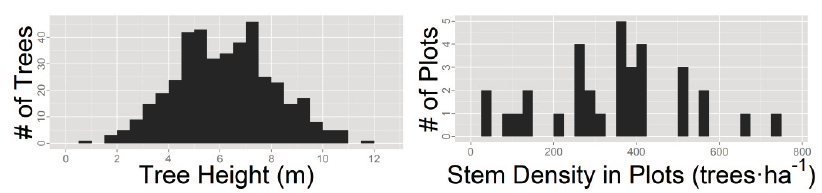
Figure 2. Histograms showing the distribution of field measured tree heights ( Left ) and the stem density of trees ( Right ) for trees >3 cm DBH in the 33 forested field plots centered on GLAS